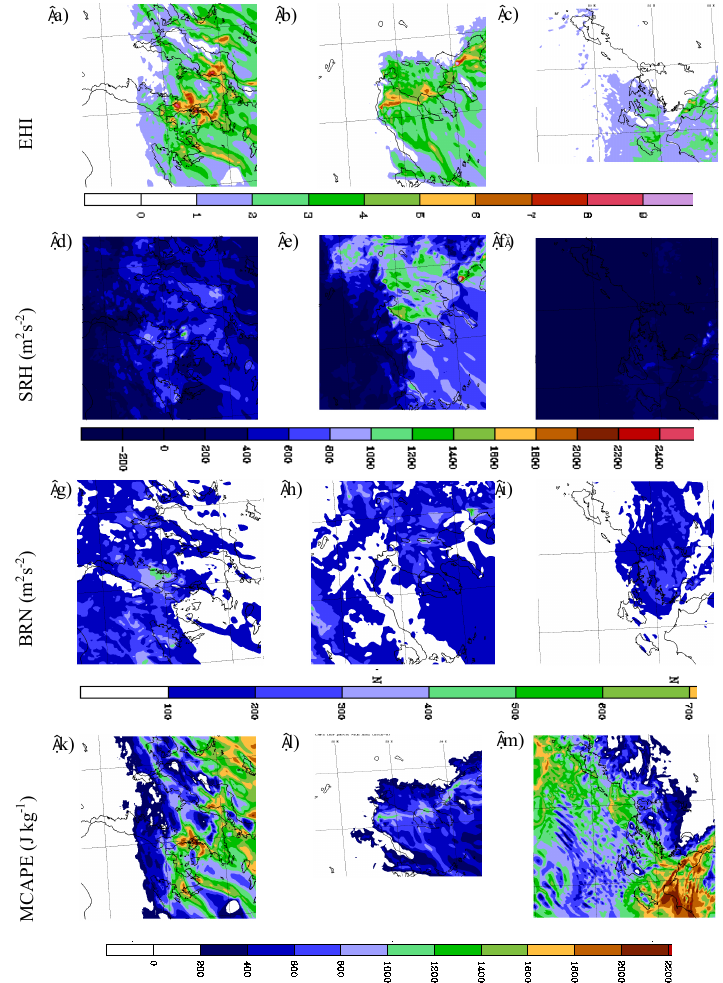
Figure 9. Spatial distribution of the four diagnostic variables of TOPOM0 simulations at the time of tornadogenesis for each tornado case (T07 left column, T10 middle column and T11 right